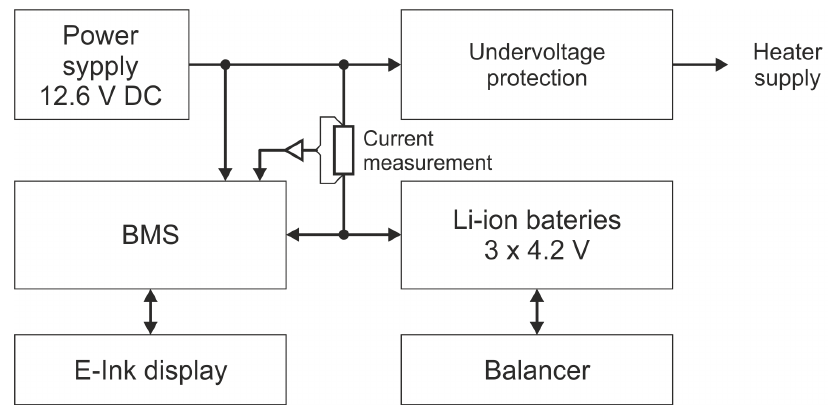
Figure 9. A block diagram of the BMS.